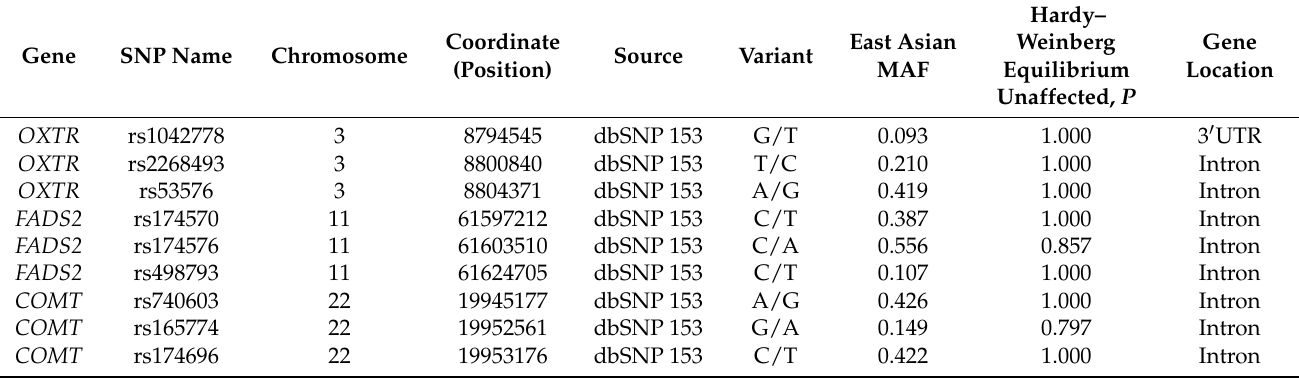
Table 1. Allele frequencies, coding information, linkage disequilibrium details, and location of